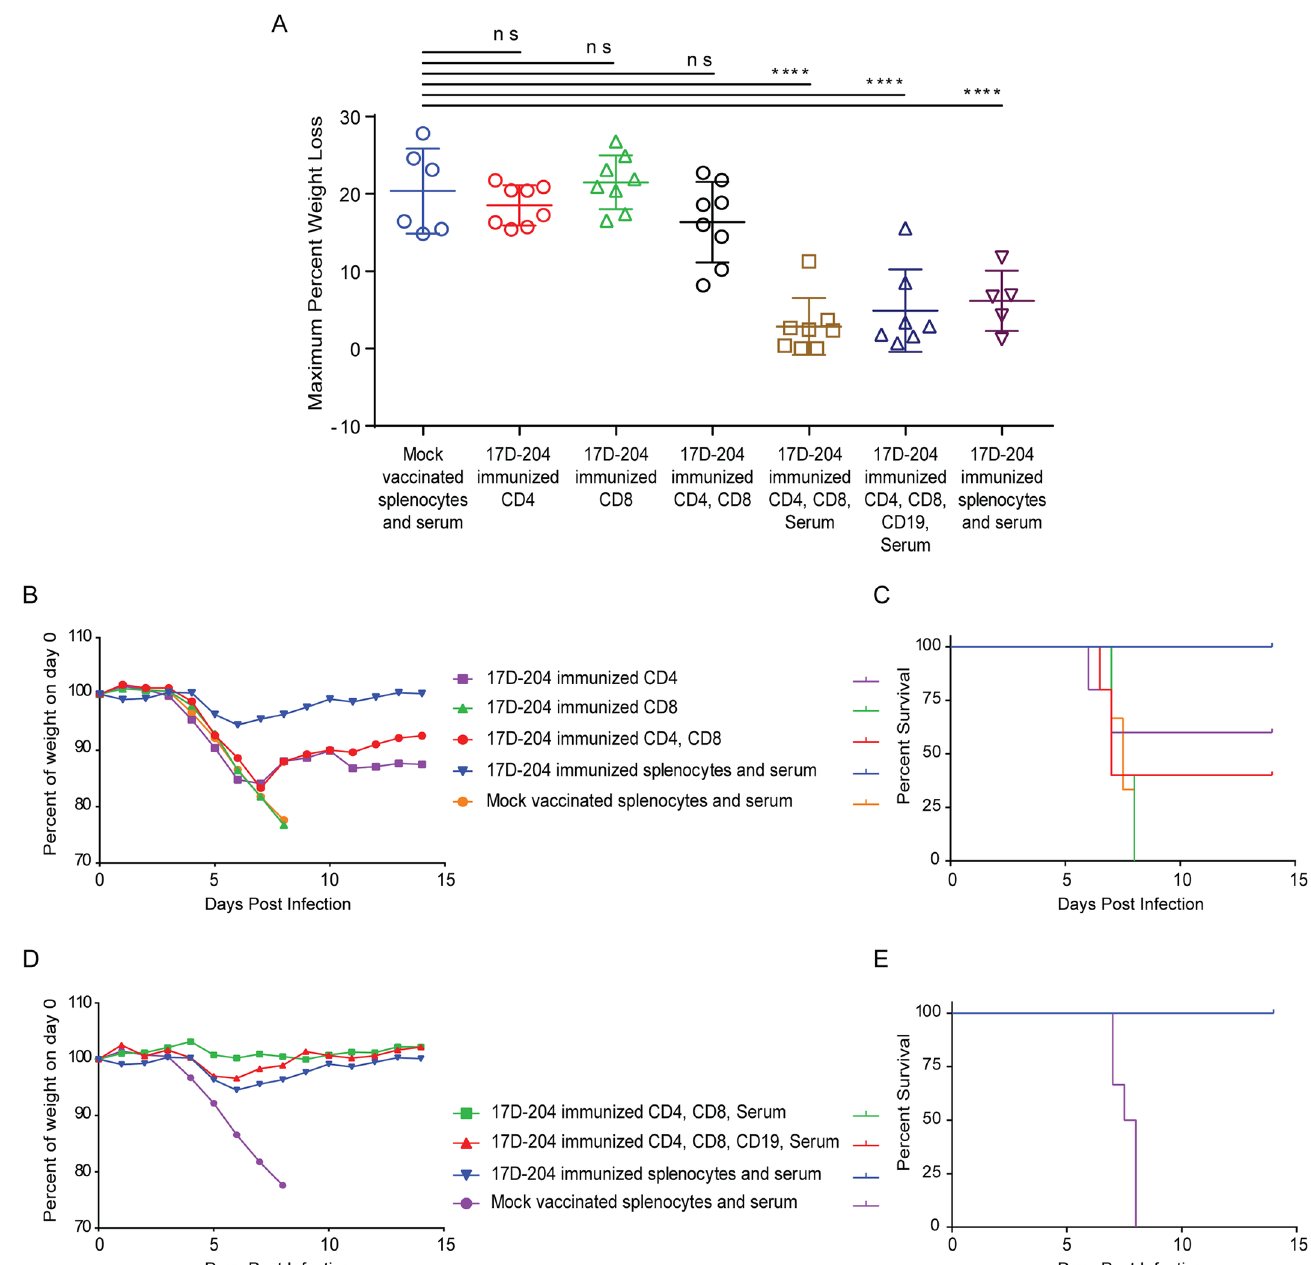
Fig 10. Complete protection against wtYFV requires serum and CD4+ T cells. Cell populations were magnetically enriched according to S2 Fig, mixed as indicated and adoptively transferred into naive eight week old mice. Some groups also received passive transfer of serum. Control groups received passive transfer of serum and total splenocytes from 17D-204 immunized or mock vaccinated animals. Twenty-four hours after the transfer, mice were challenged with Ang71 and monitored daily for (A -B, D) weight and (C and E) survival. Weight is expressed as a percentage of weight on d0 of challenge [ns, not significant; *** , p (cid:1) 0.0005; One-way ANOVA with Tukey's multiple comparisons test]. Refer to Table 1 for statistics comparing percent of survival and numbers of animals. These data are the combined results of two independent experiments. These results were acquired simultaneously with those depicted in Fig 5, and control groups are shared with those depicted in Fig